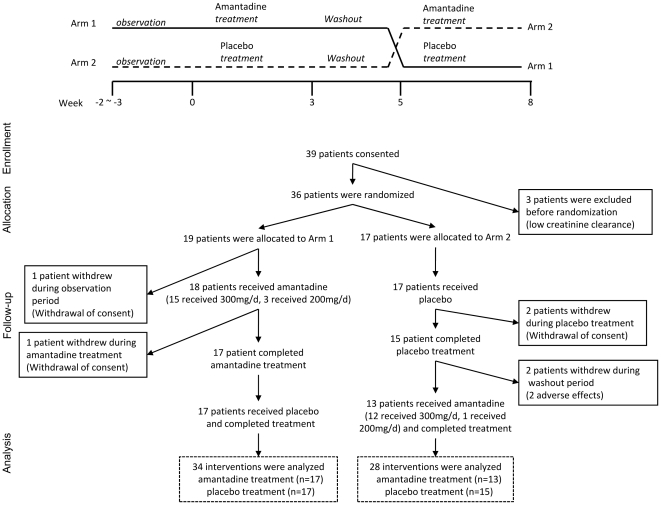
Study design and flow diagram.Top, cross-over scheme of patients randomly allocated to Arms 1 and 2. In Arm 1, amantadine was increased from 100 mg to 300 mg every 7 days, and decreased every 3 days. At 15 days after washout, placebo was administered in a similar manner. In Arm 2, placebo was increased every 7 days and decreased every 3 days, which was followed by a similar washout period and amantadine was then administered in the same fashion. Bottom, flow diagram of patients in the study.